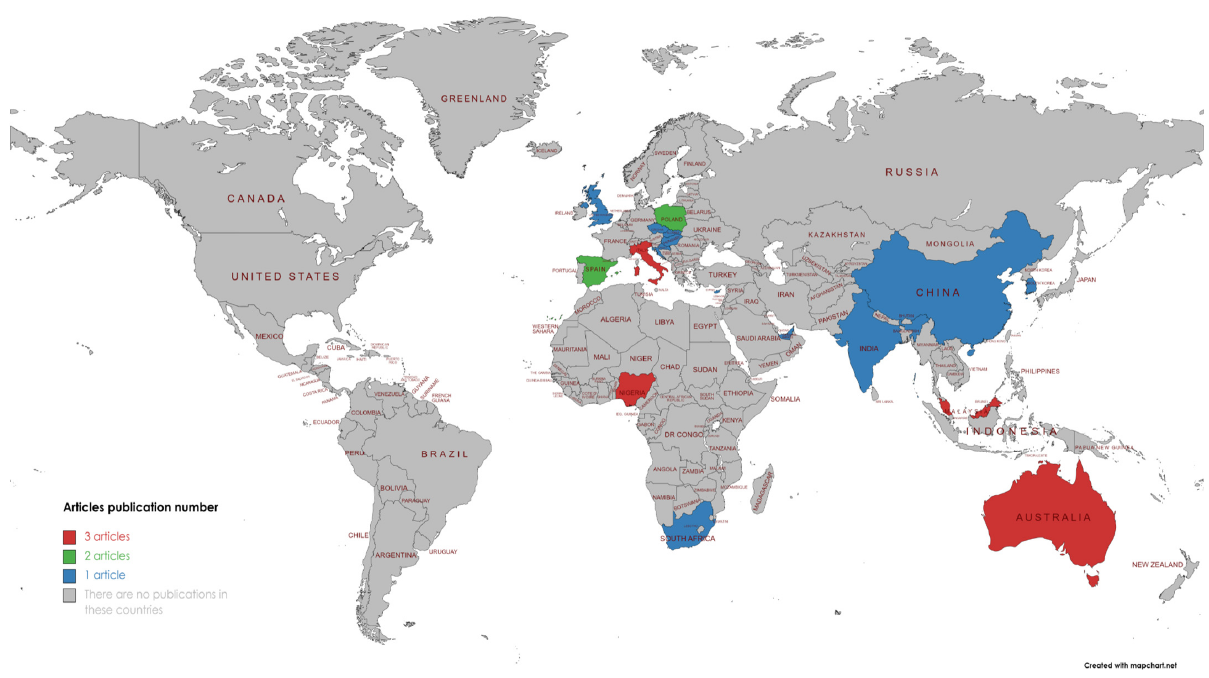
Figure 3. Countries with the highest number of publications in the last five years. Source: Own elaboration supported by MapChart tool, 2021.